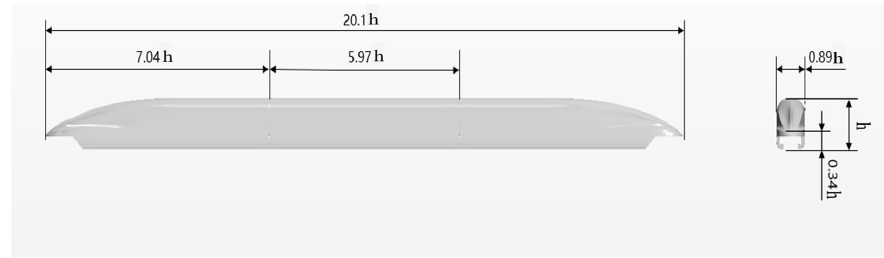
Figure 1. Maglev train model.